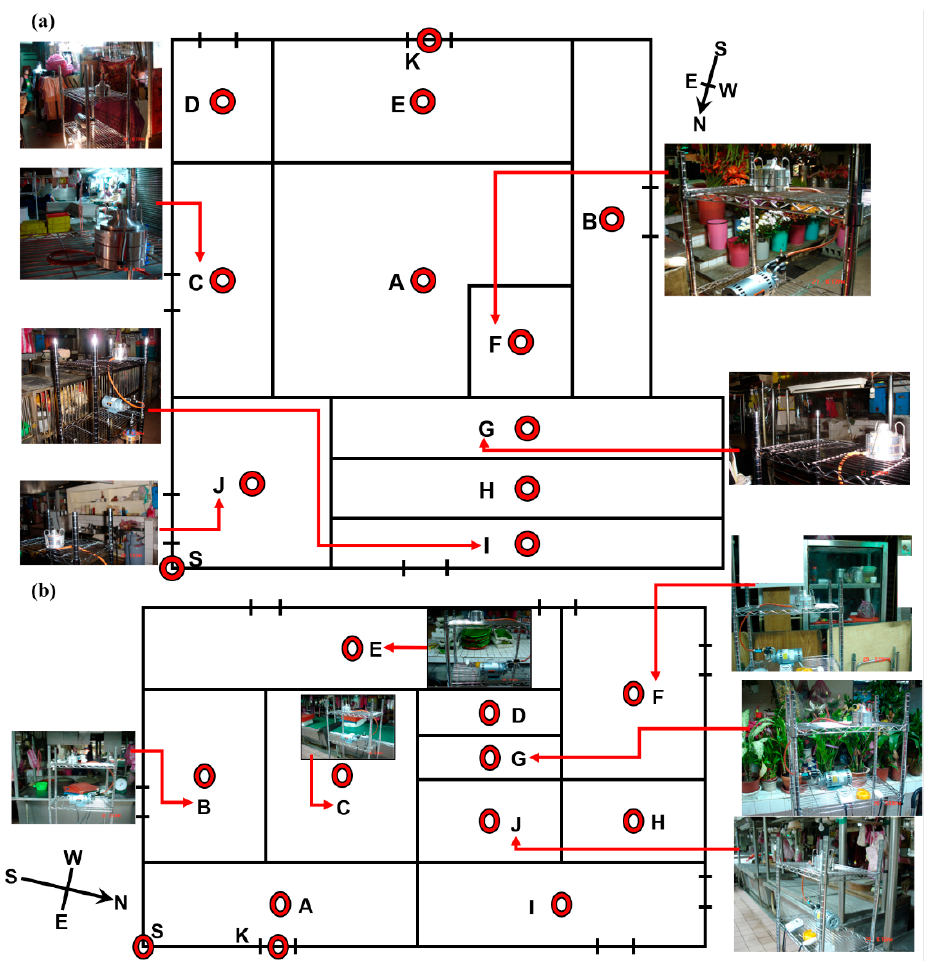
Figure 1. Bioaerosols present at the sampling locations (red circular dots) collected on the footpaths of the ten different districts; ( a ) Market A and ( b ) Market B.